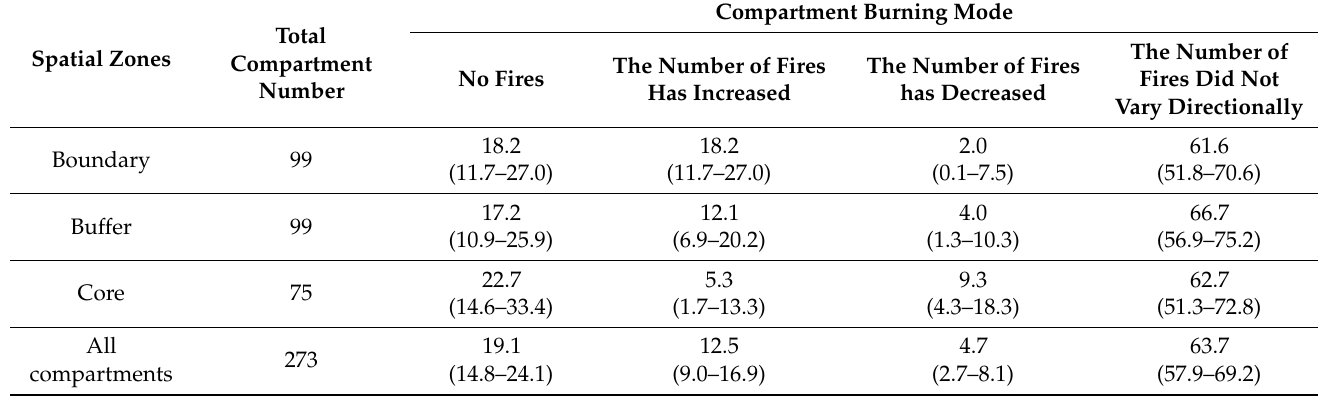
Table 3. Compartment shares (percentages) with different burning modes in different spatial zones of the Ilmensky Reserve